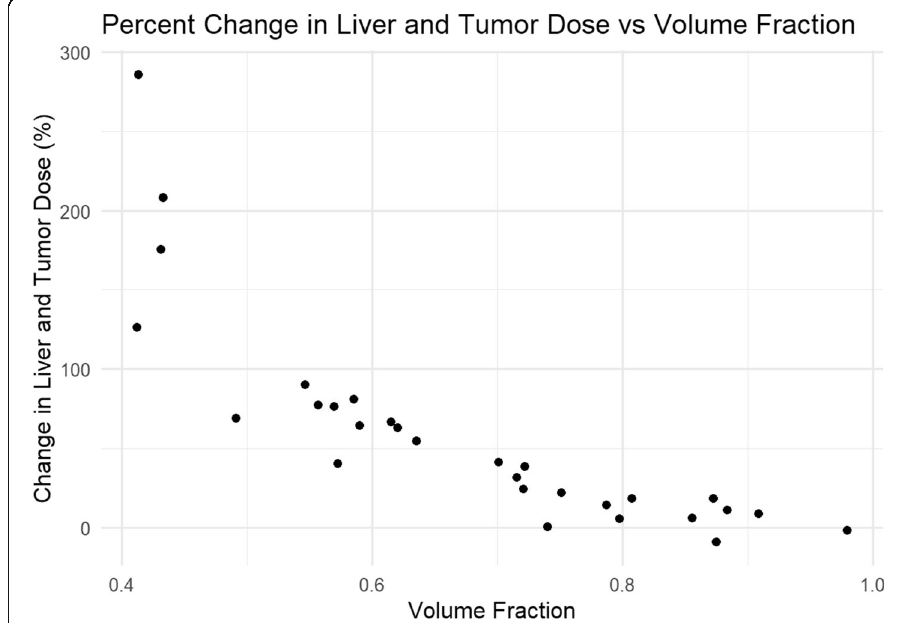
Fig. 6 Change in predicted tumor dose and normal liver dose when prescribing to 15% NTCP, instead of a 120 Gy absorbed dose to the infused volume via the standard model, is charted against the liver targeted volume